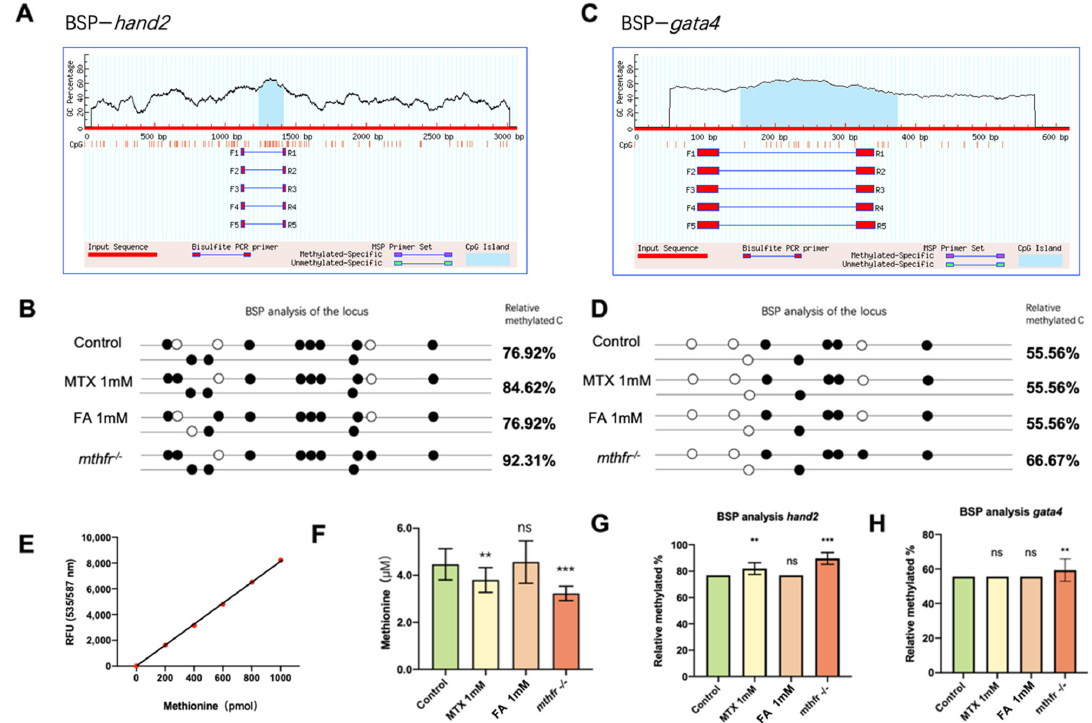
Figure 6. Effects of folic acid on partial gene methylation in zebrafish embryos. ( A ) The CpG island of hand2 gene for the BSP experiment was predicted and selected. ( B ) Zebrafish embryos with different folate metabolism groups BSP analysis of the locus of hand2 . ( C ) The CpG island of gata4 gene for the BSP experiment was predicted and selected. ( D ) Zebrafish embryos with different folate metabolism groups BSP analysis of the locus of gata4 . ( E ) Standard curve fitting based on the standard sample. ( F ) Methionine levels in heart cells of different folate treatment groups and mthfr homozygous mutants. ( G ) Relative methylated BSP analysis of the hand2 promoter locus . ( H ) Relative methylated BSP analysis of the gata4 promoter locus . (Student t -test, ** p < 0.01, *** p < 0.001, ns: no statistical difference).